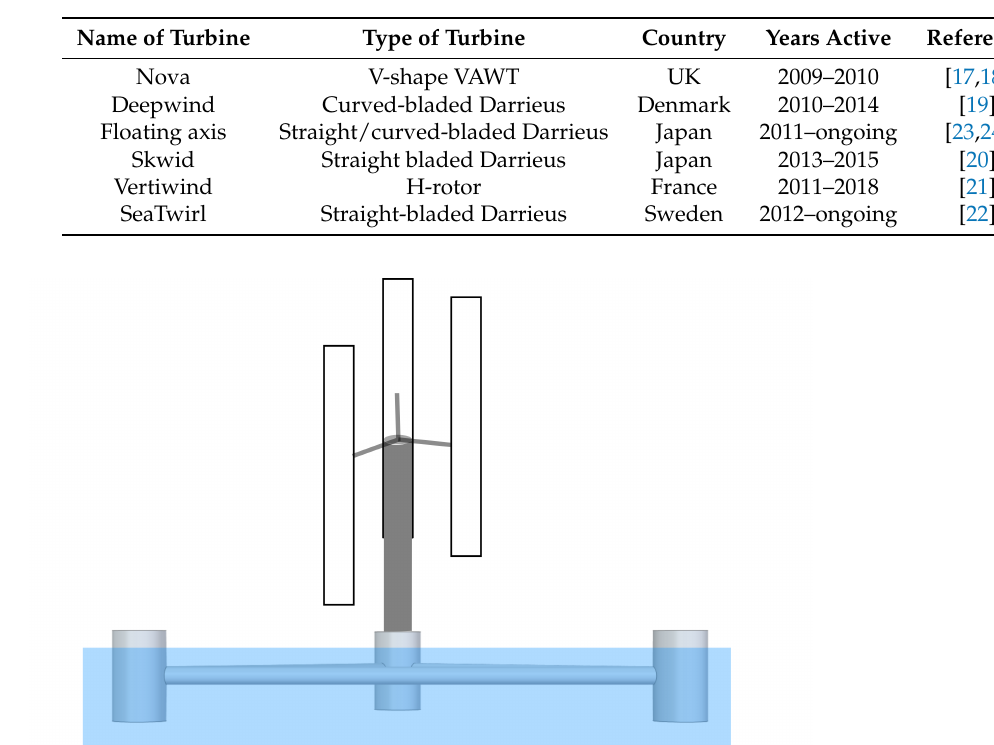
Figure 2. Schematic of a floating straight-bladed Darrieus turbine supported by a tri-floater